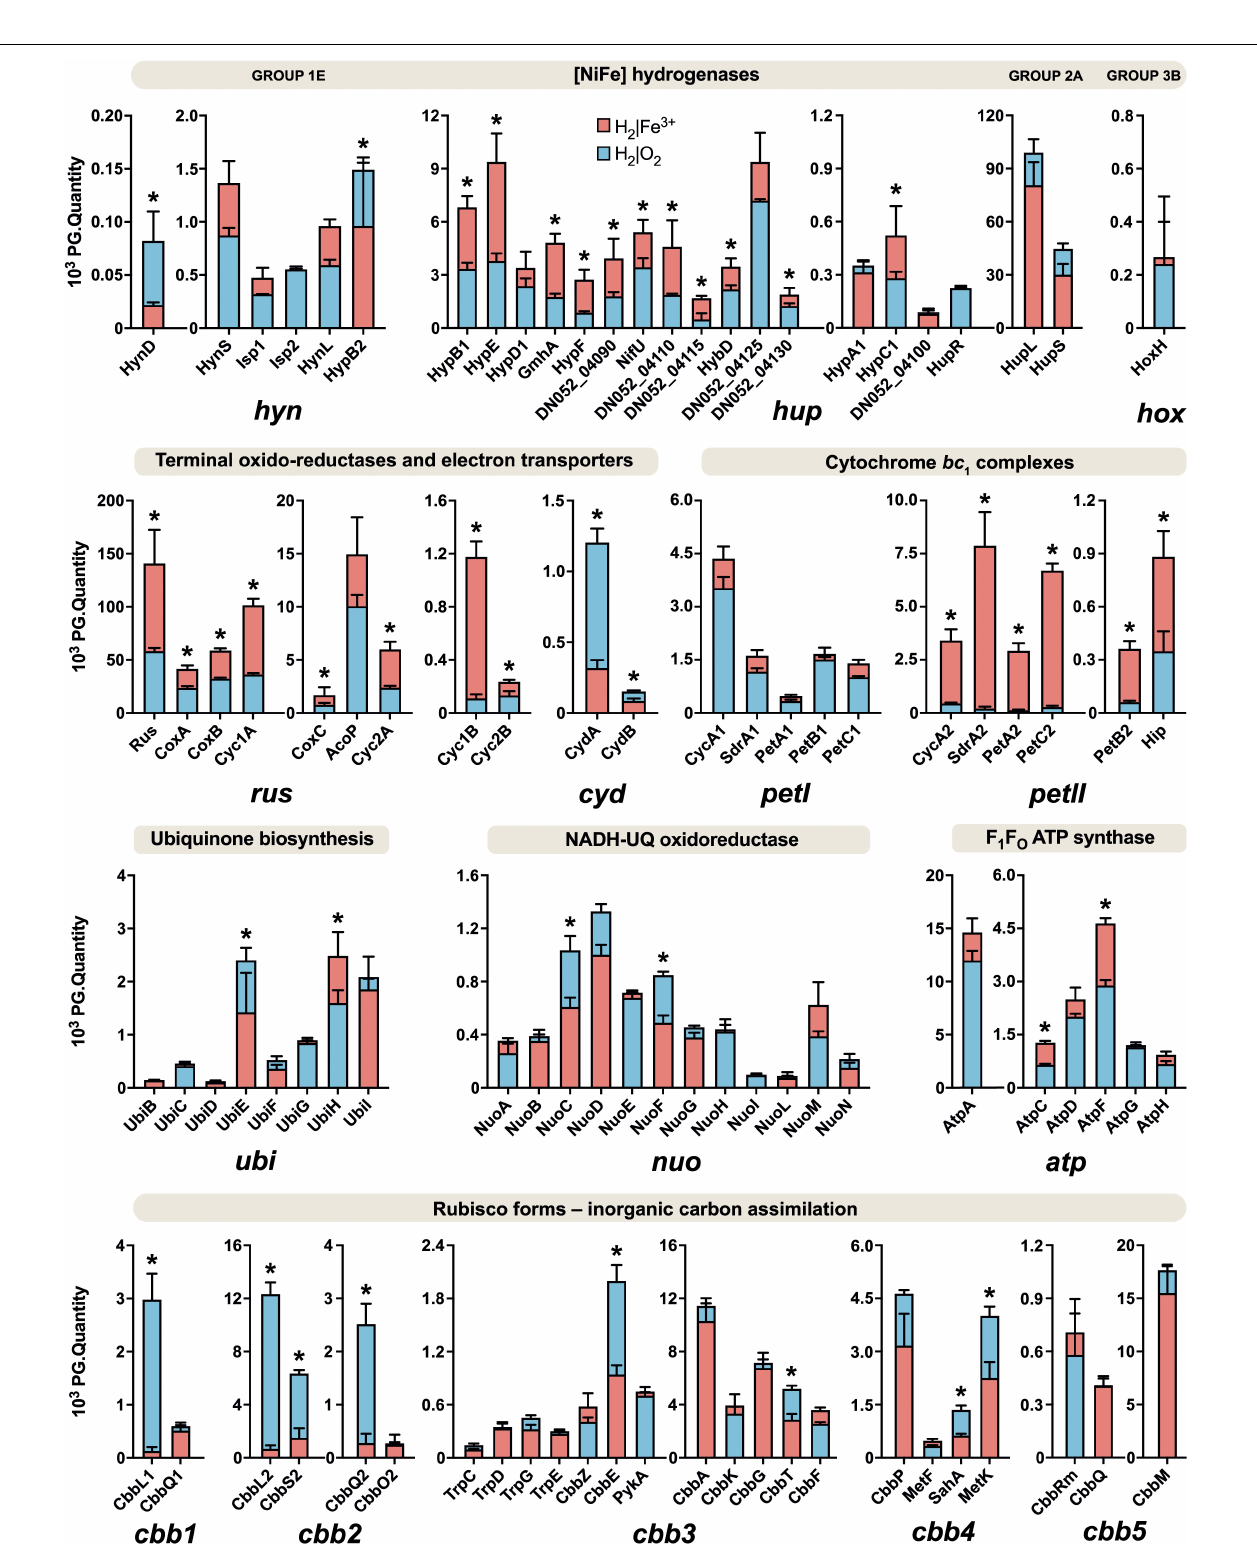
FIGURE 3 | Relative abundances of energy metabolism proteins in aerobically and anaerobically grown At. ferrooxidans cells with hydrogen as an electron donor. Blue bars represent aerobic growth (electron acceptor: oxygen), and red bars represent anaerobic growth (electron acceptor: ferric iron). An asterisk indicates a significant change between the aerobic and anaerobic growth (|log 2 fold change| > 0.58 and q < 0.05). Error bars are standard deviations of triplicate analyses.